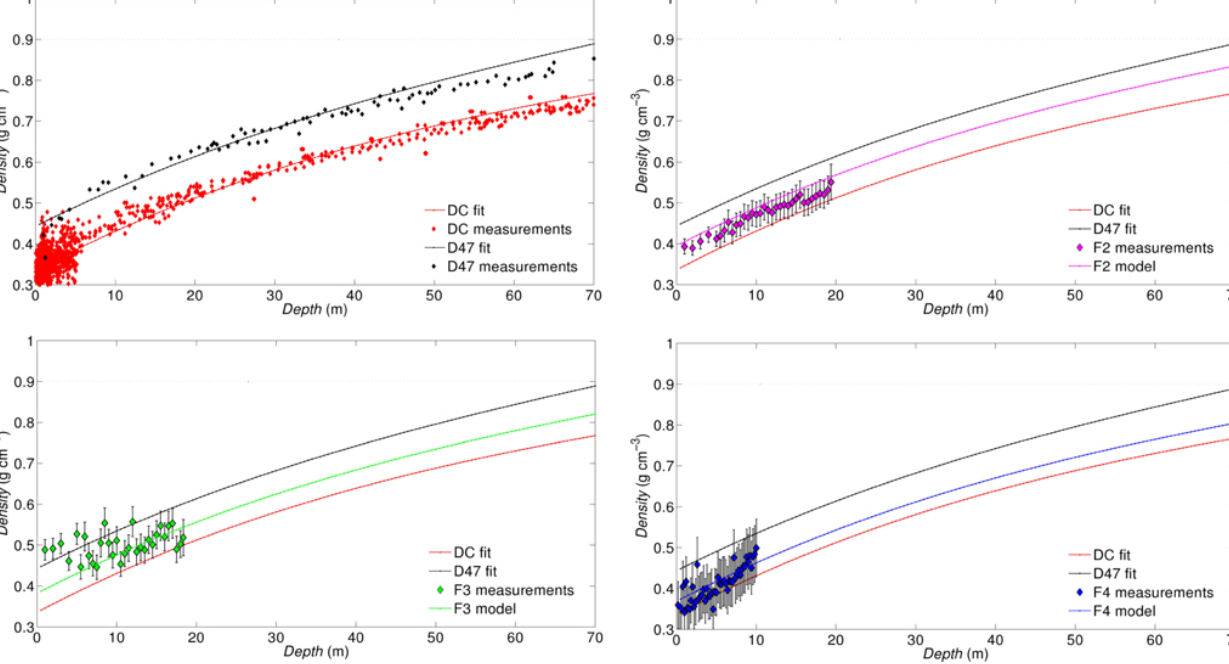
Fig. 3. Density as a function of depth. Density measurements up to 70m in depth and their fits are represented at DC and D47 (top left panel). Measured and computed density at F2 (top right), F3 (lower left) and F4 (lower right) are also displayed. Error bars for DC and D47 measurements are not represented for reasons of clarity, but are of the same order of magnitude as for shallower cores F2 to F4 ( ∼ 10%